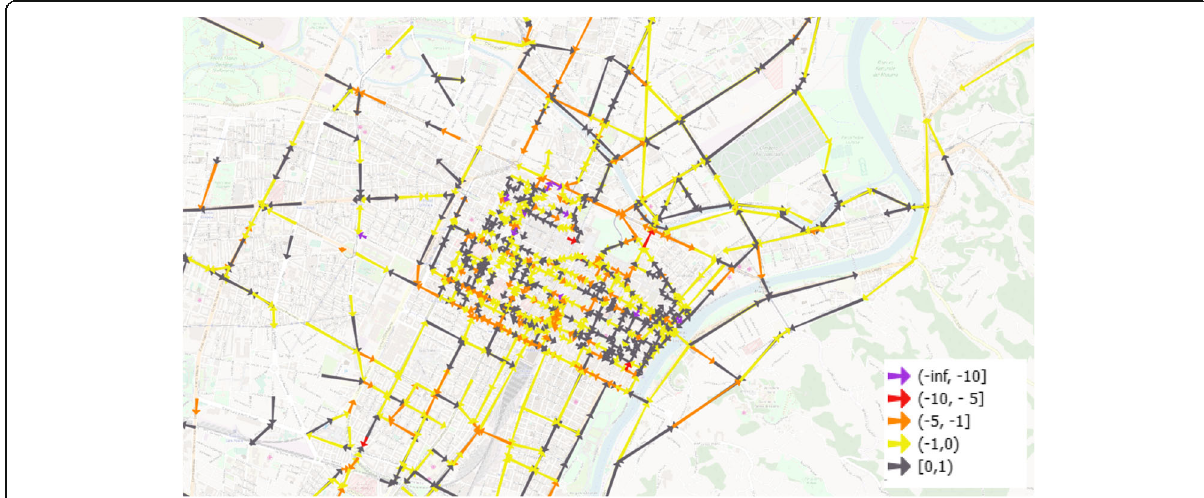
Fig. 3 Value of the mean indicator AKPI j computed for all the arcs of the road network (zoom in the city